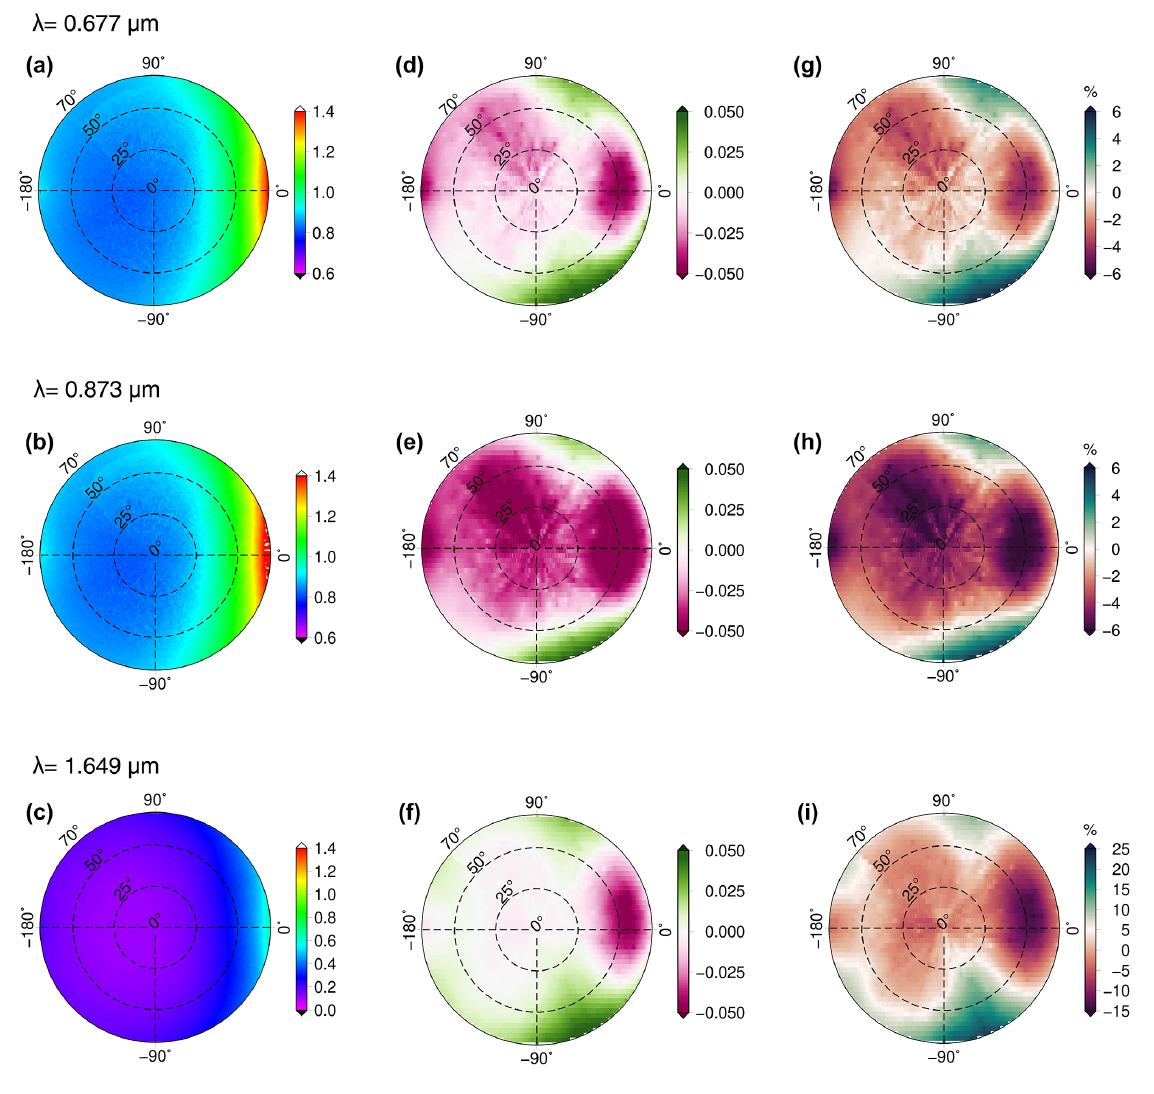
Figure 9. (a, b, c) The reflectance factor at three wavelengths, namely 0.677, 0.873, and 1.649µm, from the CAR measurements acquired on 7 April 2008 at Barrow/Utqia˙gvik, Alaska, at an altitude of 647m. (d, e, f) The absolute difference between reflectance of simulation (RSCIATRAN) and that of measurement (RCAR): (RSCIATRAN − RCAR). (g, h, i) The relative difference in percent